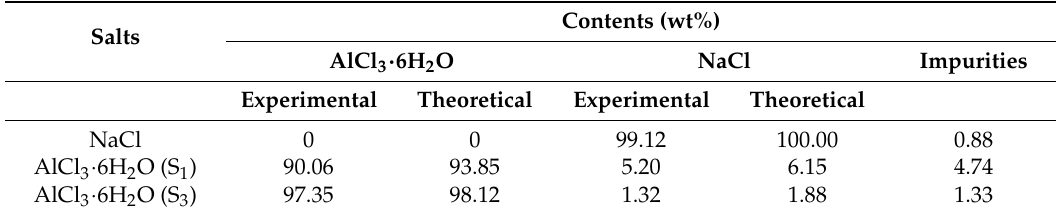
Table 1. The purities of precipitated